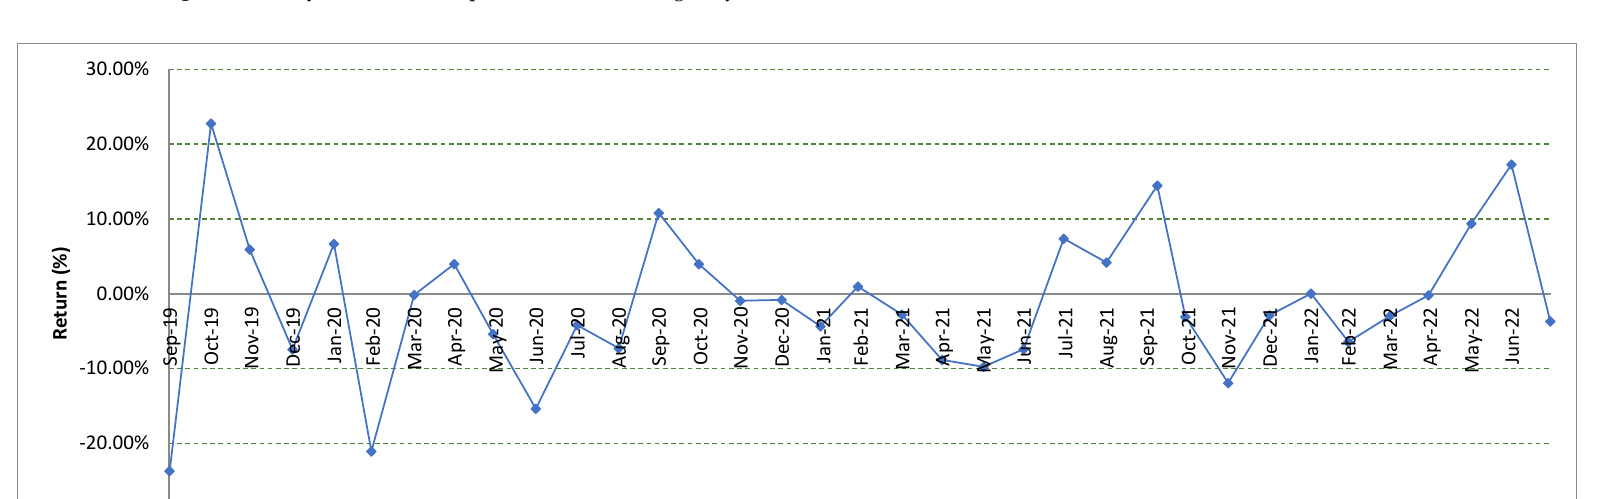
Figure 6. Utility-maximization portfolio ( A = 5): long-only.